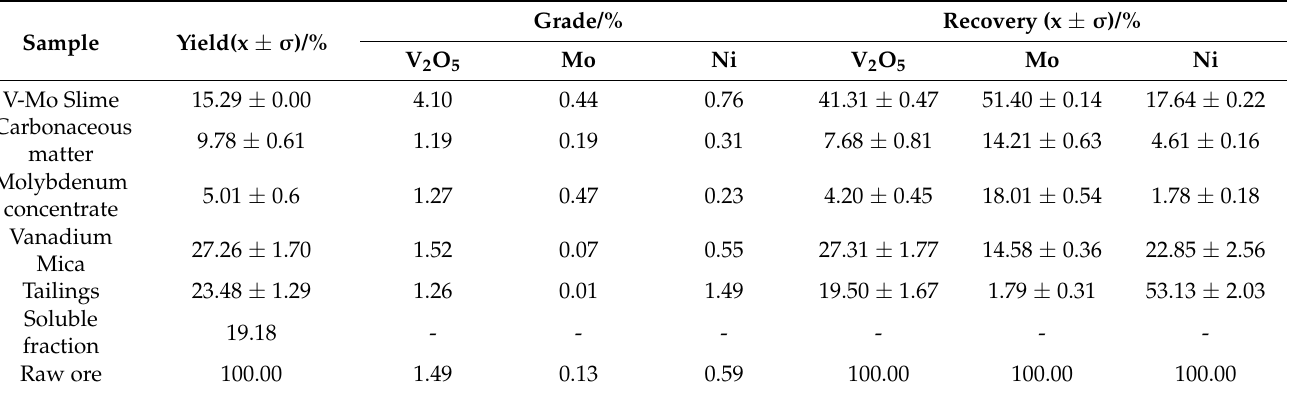
Table 8. Experimental results for scrubbing–desliming–flotation.